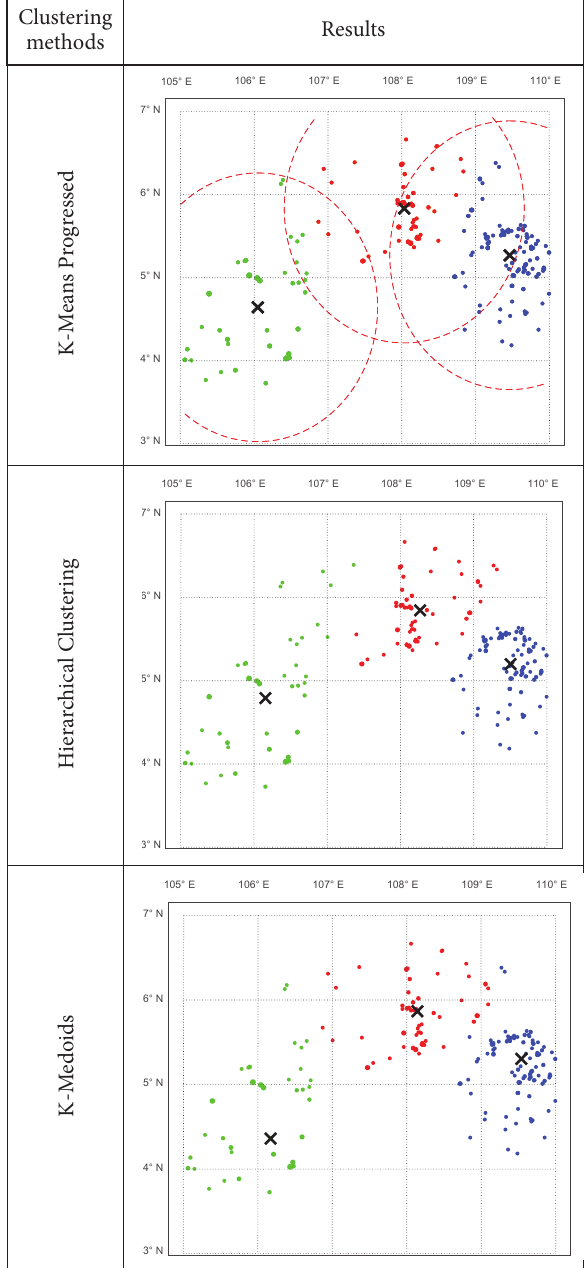
Table 2. Comparison of clustering methods Clustering methods